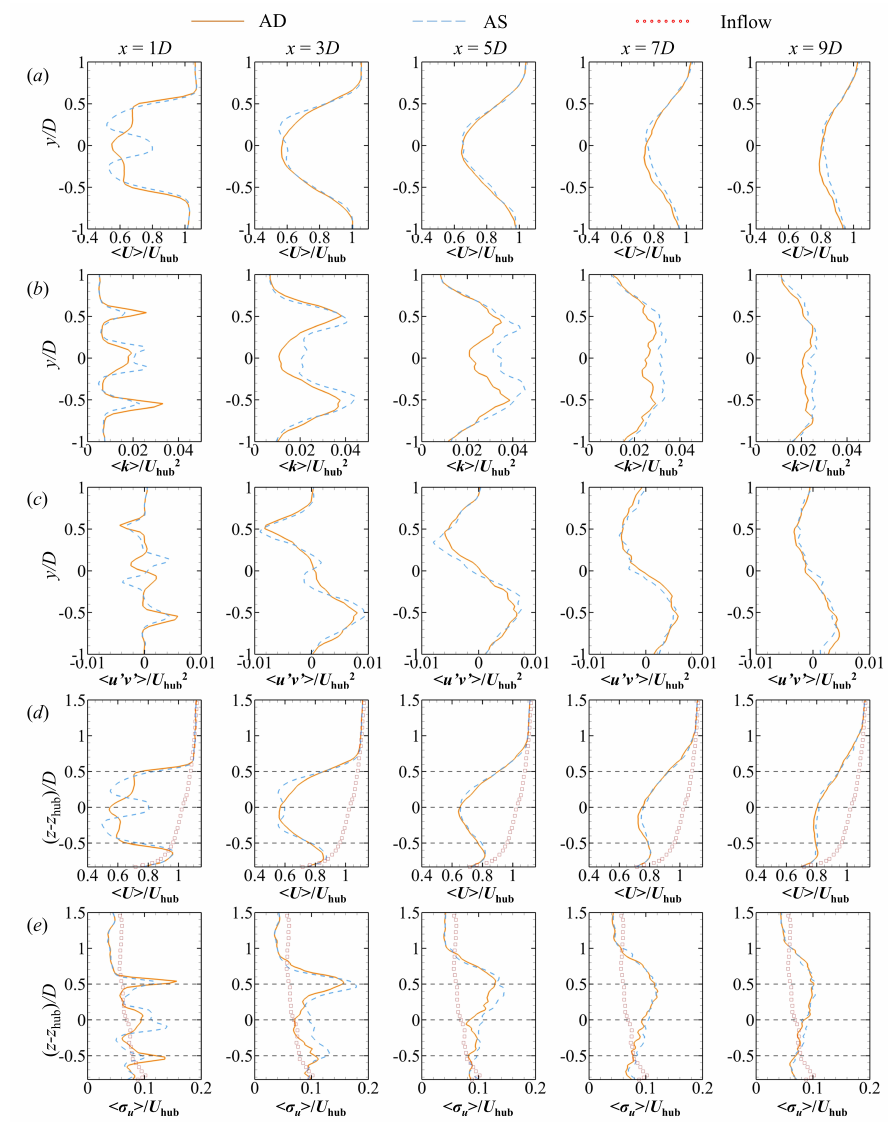
Figure 6. Turbulent inflow: Horizontal profile of time-averaged ( a ) streamwise velocity, ( b ) turbulence kinetic energy, and ( c ) the primary Reynolds stress < u (cid:48) v (cid:48) > at different downstream location at hub height ( z = z hub ); vertical profile of time-averaged ( d ) streamwise velocity and ( e ) turbulence intensity on the plane y =